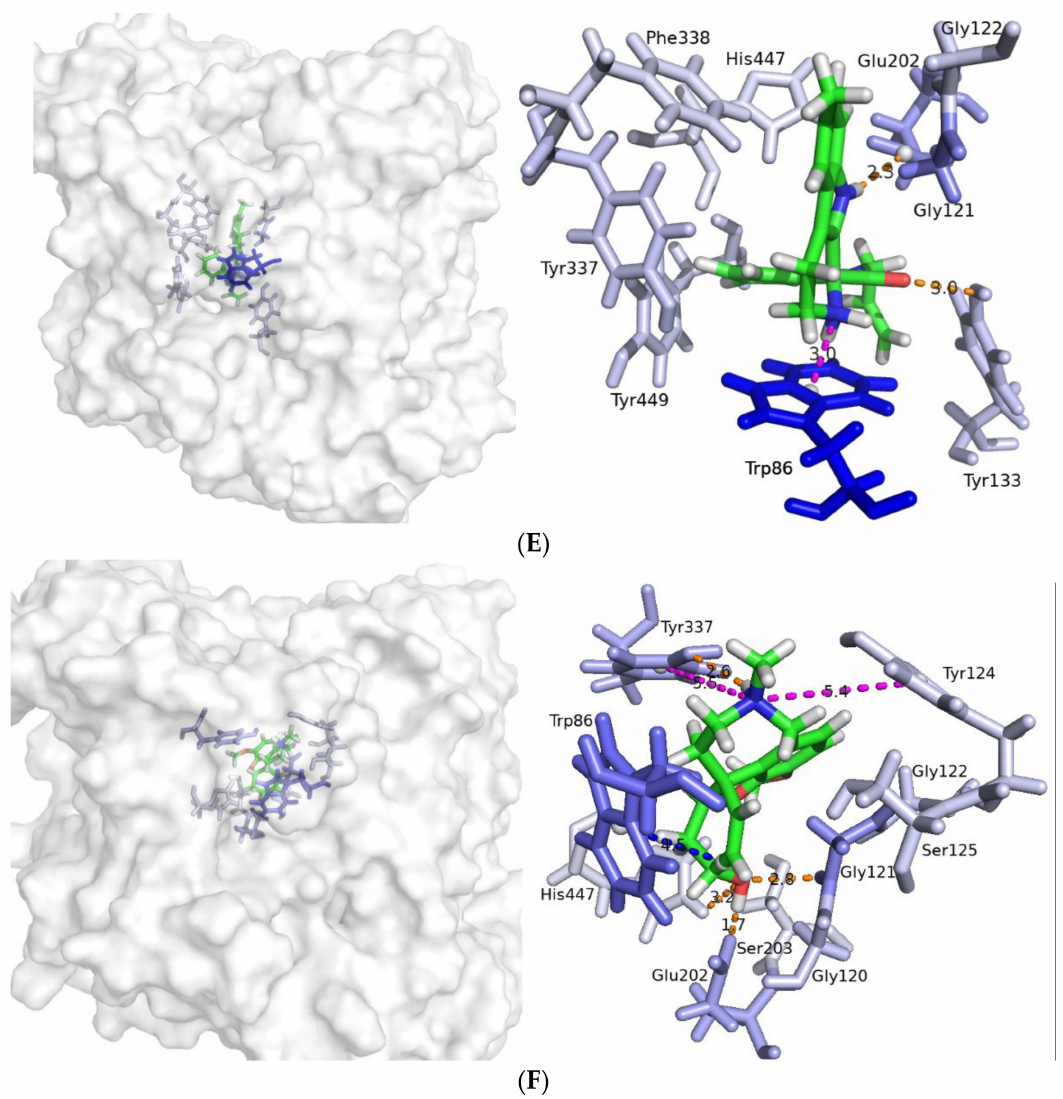
Figure 5. Intermolecular interactions between AChE and compound ( A ) 22 (in 329.8 ns), ( B ) 28 (in 486.4 ns), ( C ) 21 (in 988.4 ns), ( D ) 9 (in 557.6 ns), ( E ) 29 (in 654.8 ns), and ( F ) GAL (364.8 ns). Hydrogen bonds are denoted as orange dashes. Distances between center of mass of π – π or π –p electrons, prerequisite for π – π stacking or π –p contact, are denoted in blue dashes. Cation– π distances are presented in magenta. Salt bridges are denoted with green dashes. Distances are presented in Å. Residues are colored according to their energy contribution—blue colored ones favor the binding, while red colored do not favor it. More saturated color indicates higher contribution. Ligands are colored by